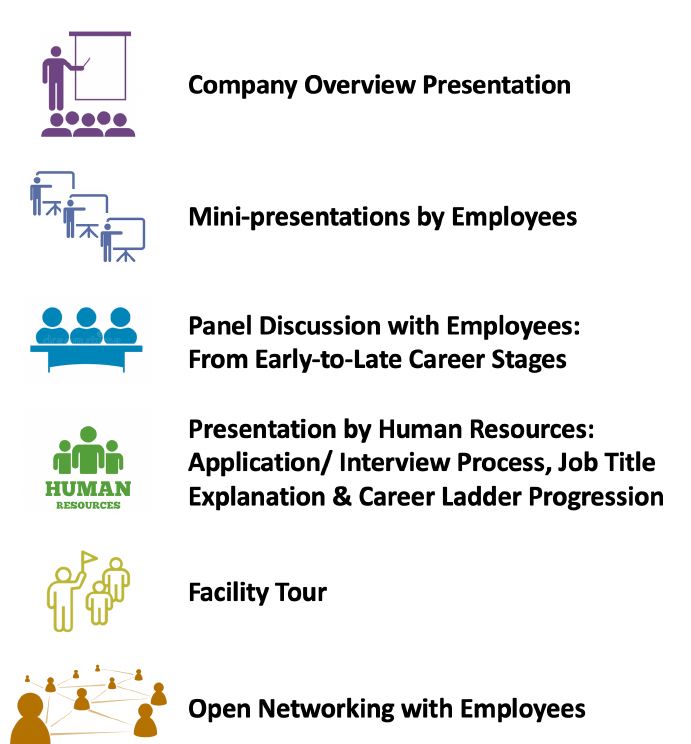
Figure 2. Examples of ELITE Consortium site visit activities. There are six key activities that may take place during a site visit, ranging from an overview of the company’s activities to networking with individual scientists at the